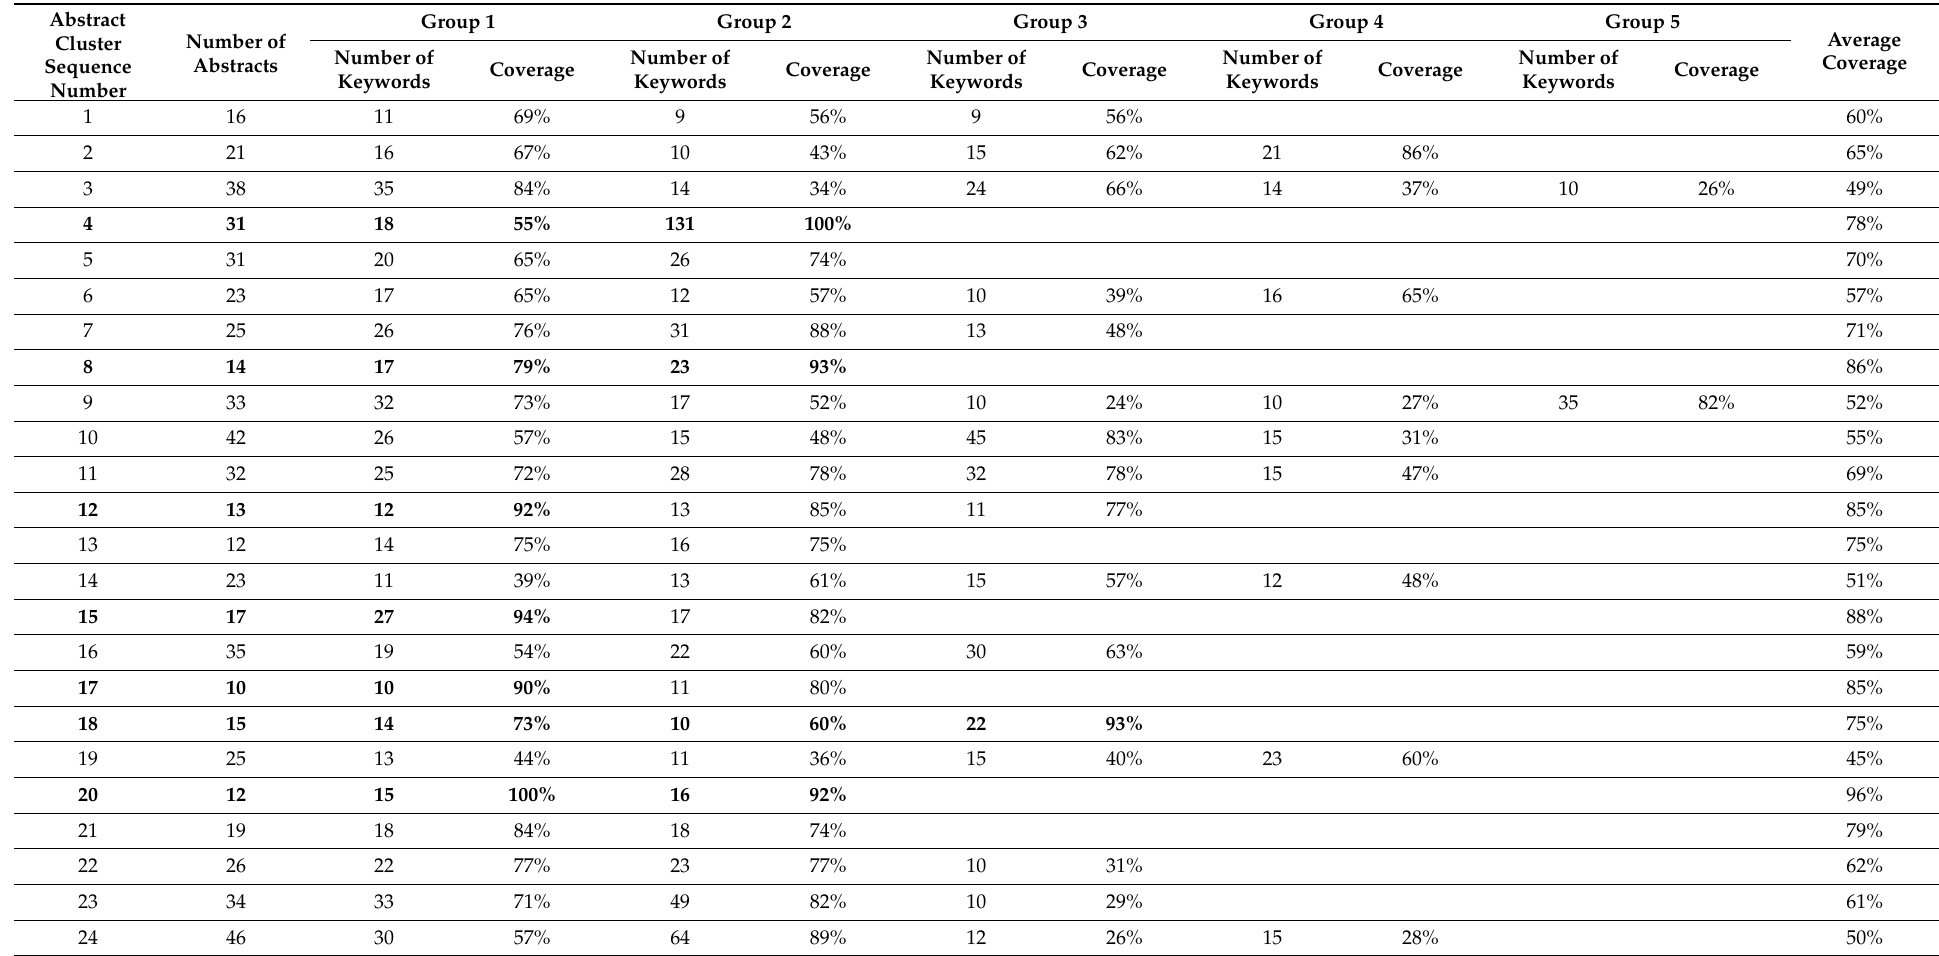
Table 3. Statistics of keyword groups in abstract clusters: the number of abstracts, number of keywords, and coverages. Note: the sequence numbers in the first column reference the abstract sequence numbers in Table